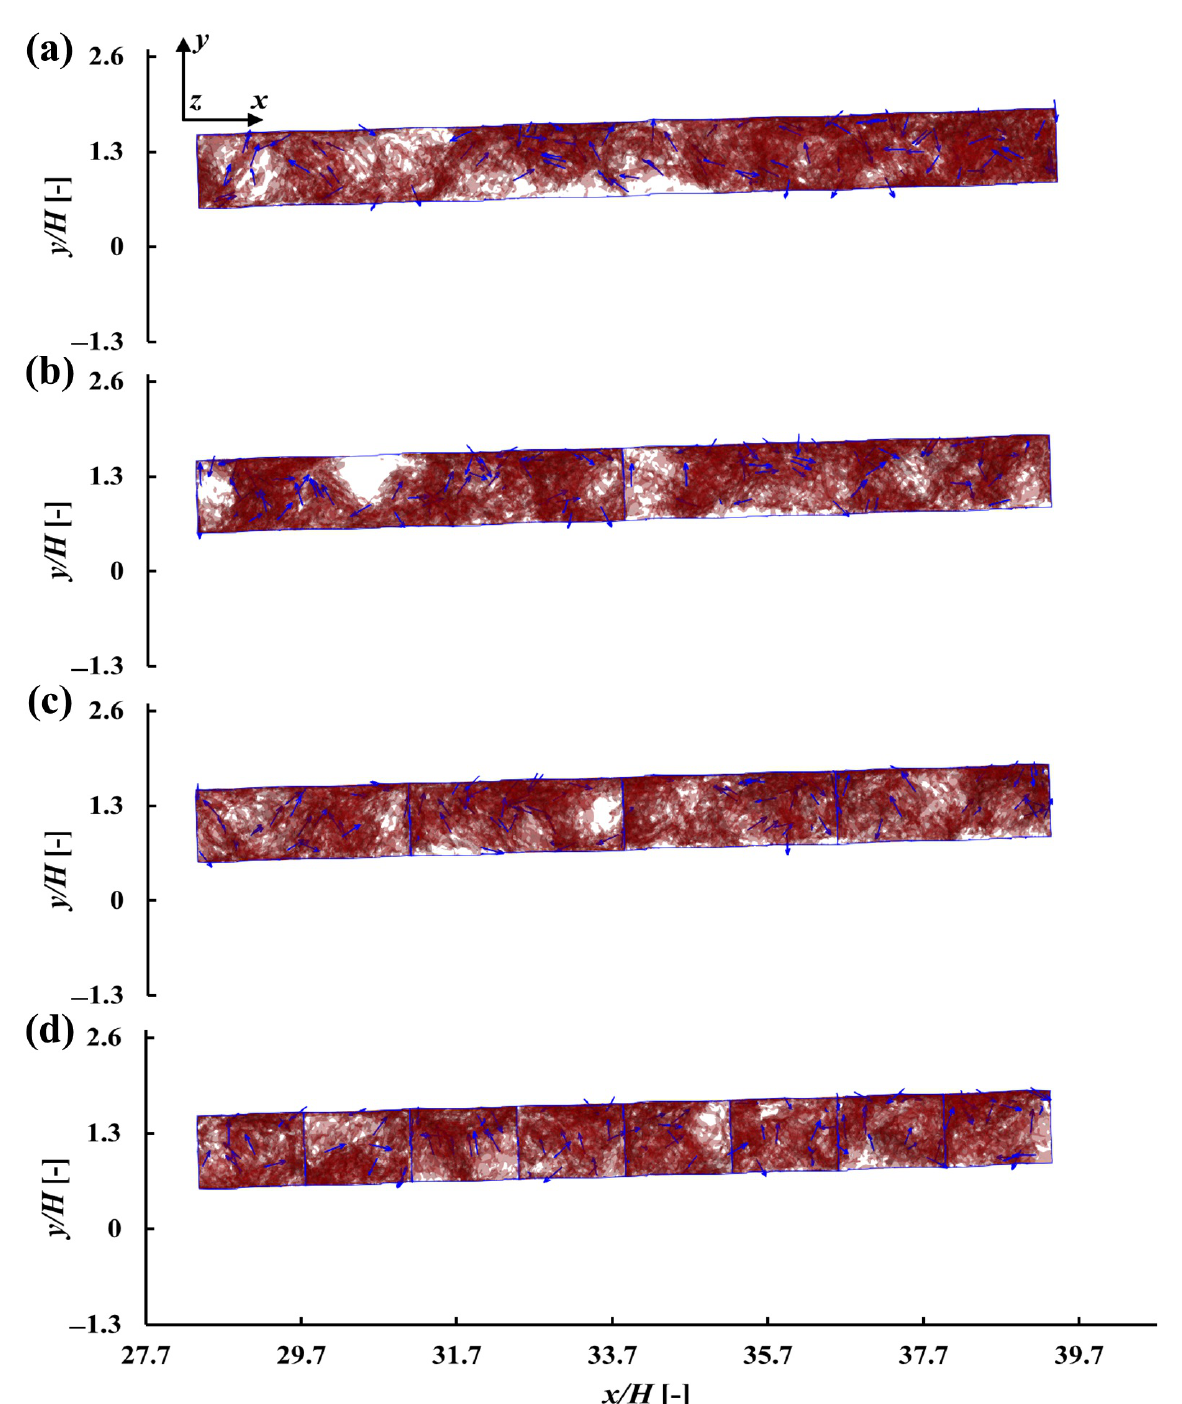
Figure 24. Snapshots for the sloshing tank with D i = 1.0 at t / T = 5.5 for ( a ) N c = 1, ( b ) N c = 2, ( c ) N c = 4 and ( d ) N c = 8. Water phase is shown as transparent red with dark red representing the free surface. Blue arrows show the general direction of motion of the sloshing